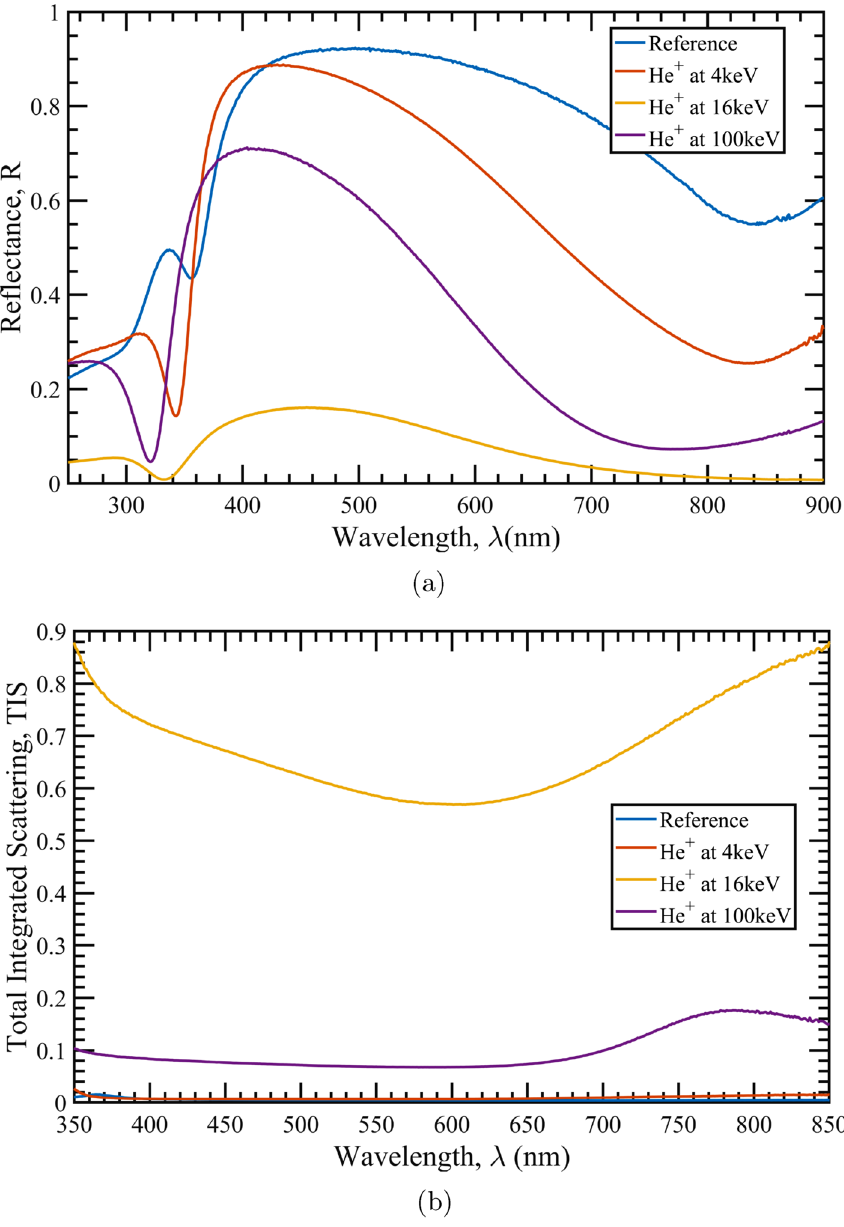
Figure 2. ( a ): Spectral reflectance of the TiO 2 /Al samples irradiated at different energies. ( b ): Total integrated scattering (TIS) measured for indicated the